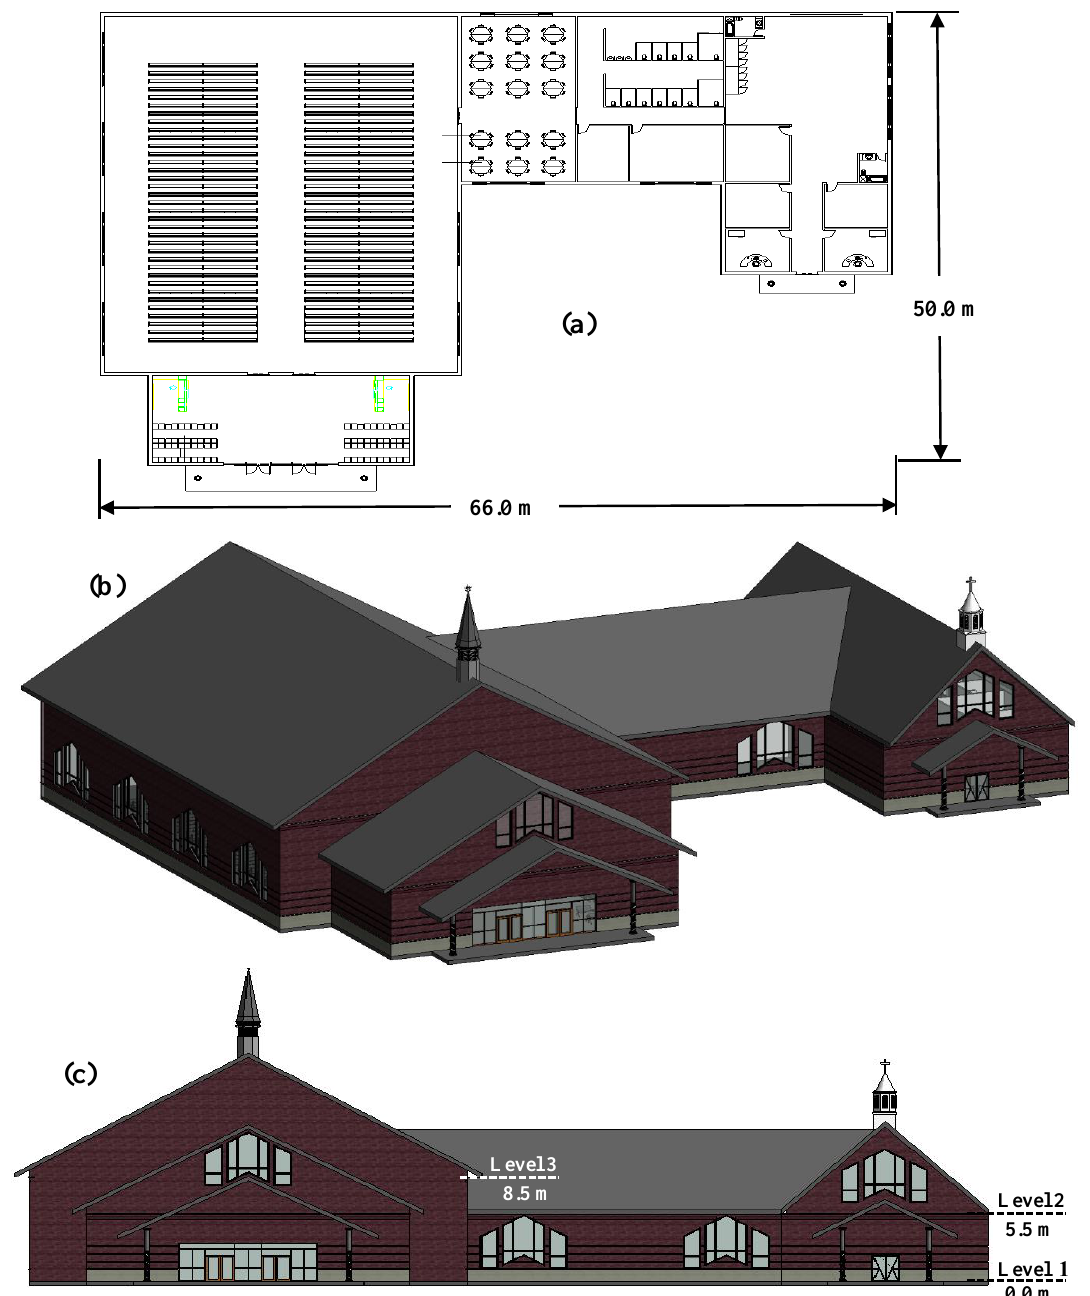
Figure A12. F13 archetype plans and sections: ( a ) Plan view; ( b ) 3-D view for the church; ( c ) Side view for the whole church.